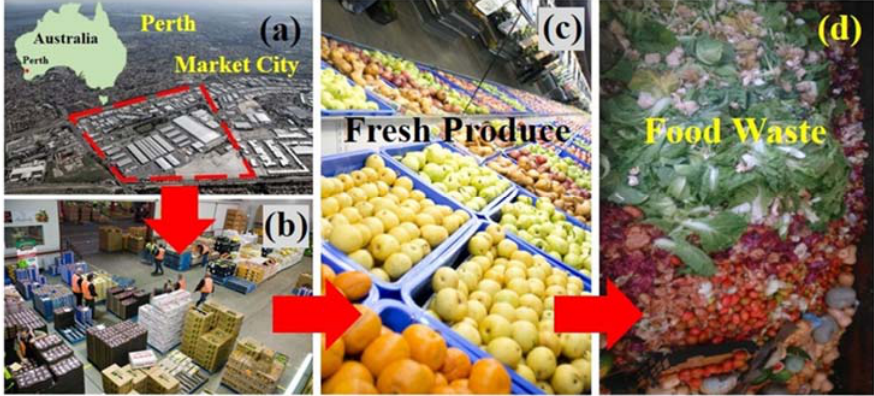
Figure 1. ( a ) Aerial view of Market City Canning Vale, Perth, Western Australia; ( b ) wholesalers at work in the market; ( c ) typical examples of fresh produce sold at the market; and ( d ) a representative